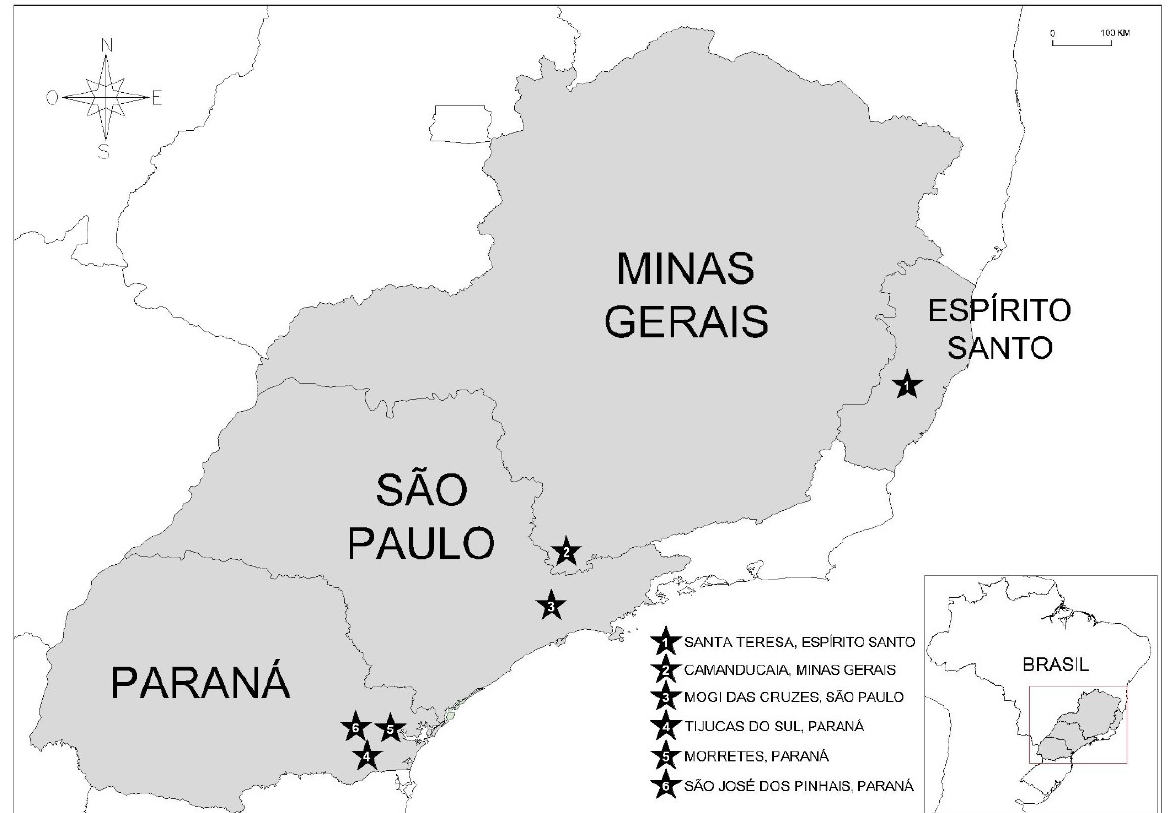
Figure 1. The collecting localities of the specimens analyzed in the present